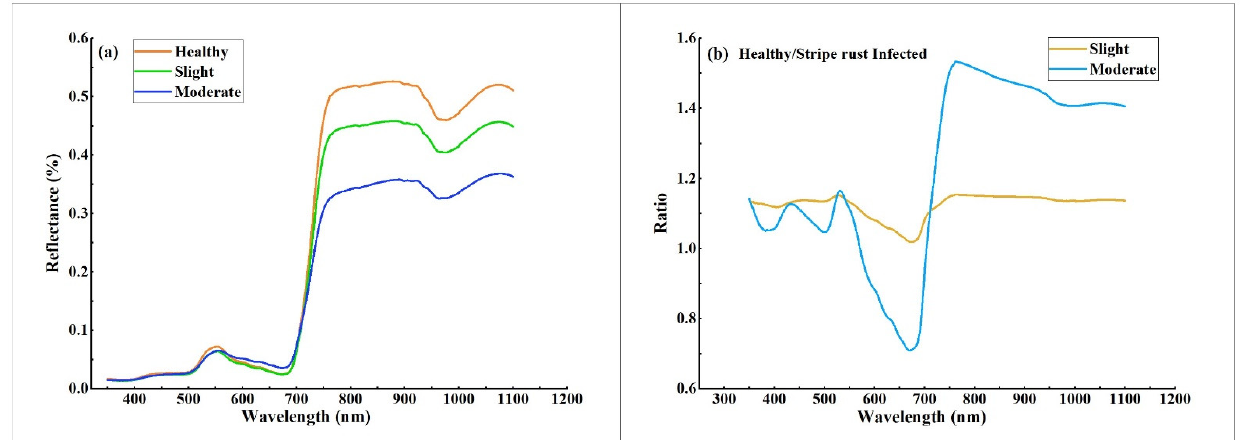
Figure 4. ( a ) The average canopy spectral reflectance of different stripe rust infection levels; ( b ) The spectral ratios of stripe ‐ rust ‐ infected wheat compared to healthy winter wheat.